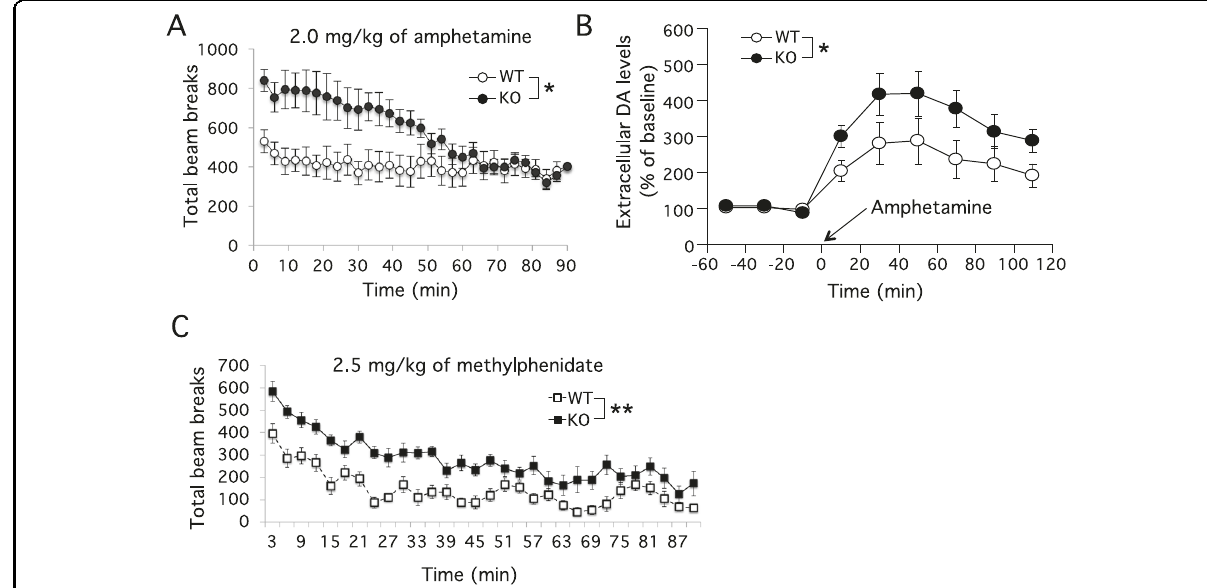
Fig. 4 Enhanced locomotion in response to amphetamine and methylphenidate treatment for adult male zdhhc15 -KO mice. Mice were fi rst given i.p. injection of the indicated drugs and then placed in open- fi eld chamber immediately for measurement of locomotion. A Amphetamine treatment of zdhhc15 -KO mice resulted in higher levels of locomotion compared to WT controls in open fi eld and this effect was most prominent during the fi rst 60 min (2.0mg/kg, i.p. injection at time = 0 min; n = 9 – 10 animals per group, factorial repeated measures ANOVA, p = 0.03). B Z dhhc15 -KO mice showed an increase in extracellular dopamine level in ventral striatum in response to amphetamine. The extracellular levels of dopamine during baseline phase (60 min), and amphetamine (2.0 mg/kg, i.p.) phase (120min) were measured in the nucleus accumbens by microdialysis ( n = 6 mice per group, factorial repeated measures, ANOVA, p = 0.047). C Methylphenidate treatment resulted in an increase in locomotion in zdhhc15 -KO mice compared to WT controls (2.5 mg/kg, i.p. injection at time = 0 min; n = 9 – 10 animals per group, factorial repeated measures ANOVA, p =